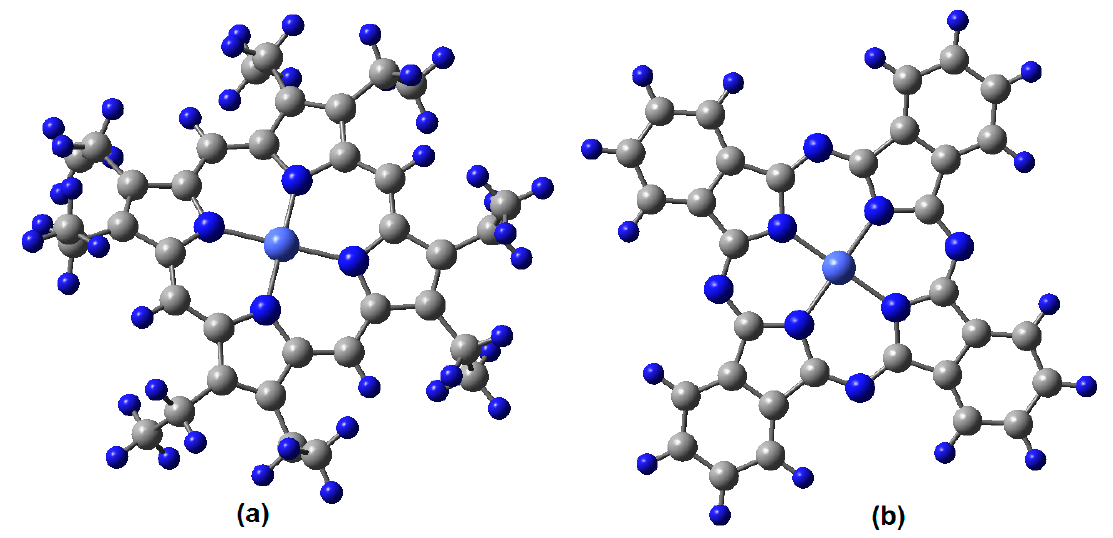
Figure 1. ( a ) Cobalt(II) octaethylporphyrin complex and ( b ) Cobalt(II) phtalocyanine complex.